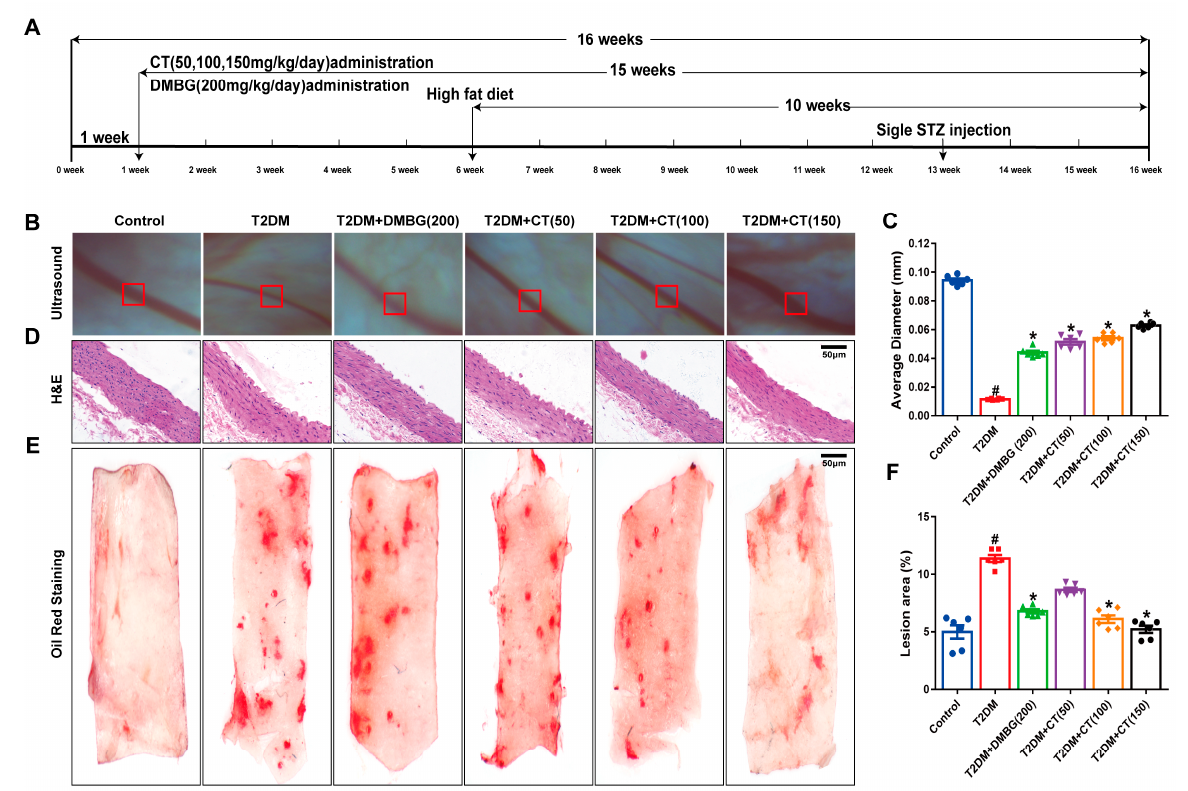
Figure 1. CT alleviated arterial stenosis and carotid lipid deposition in T2DM rats. ( A ) Flow chart of animal experiment. ( B ) Fundus retinal artery stenosis was examined by ophthalmoscope. ( C ) Quantitative analyses of the average diameter of retinal artery was performed. ( D , E ) HE staining and Oil red staining of carotid artery. ( F ) Quantitative analysis of carotid artery lipid plaque (N = 6). Data were analyzed by one-way ANOVA by Tukey post hoc tests or Bonferroni post hoc analyses. All data were expressed as mean ± SEM. # p < 0.05 vs. Control group, * p < 0.05 vs. T2DM